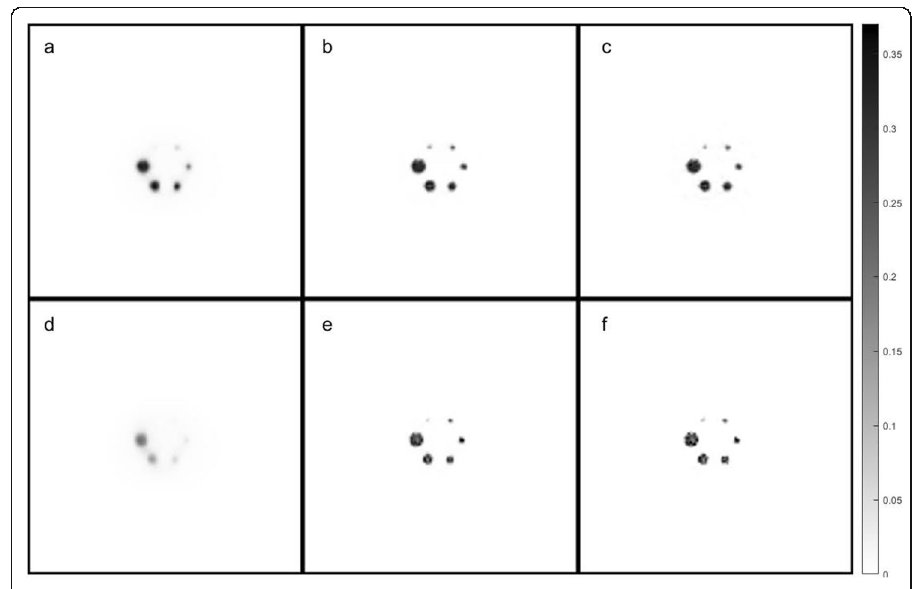
Fig. 7 Transverse slice of the IEC phantom through the center of the hot spheres acquired with the phantom in the center position with 3.76GBq of 131 I in the background. The images on the top row ( a – c ) were reconstructed with OSEM using TOF information with 16 subsets and 2, 25, and 100 iterations, respectively. In the second row ( d – f ), images were similarly reconstructed but without making use of TOF